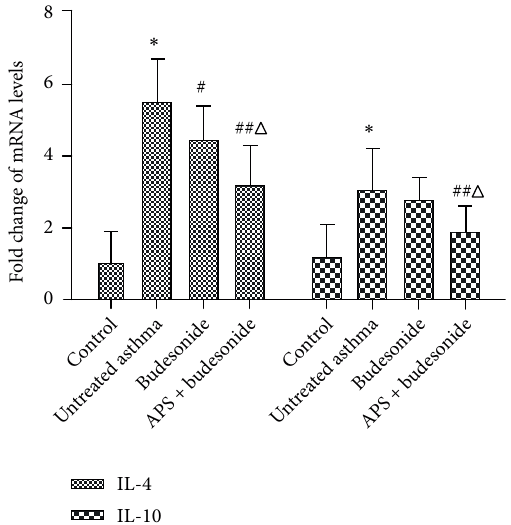
Figure 3: APS and budesonide suppressed mRNA levels of inflammatory mediators. Relative expression of IL4 and IL10 mRNA levels were measured by RT-PCR and is represented above. Every independent experiment was triplicated. Mean ± SD is presented for each group. 𝑃 < 0.01 , compared with control group; # 𝑃 < 0.05 , compared with untreated asthma group; ∗